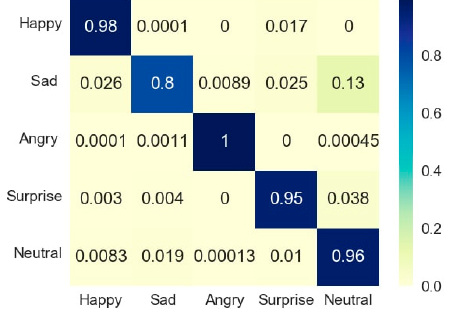
Figure 8. Confusion matrix of MHL-based emotion recognition results for the complete